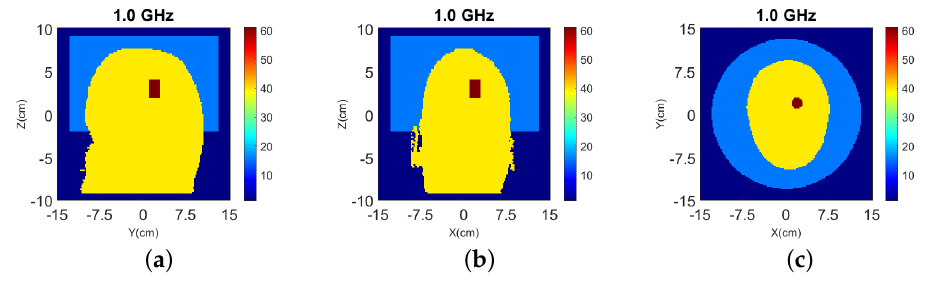
Figure 15. True values of (cid:60) ( ε r ) of Case III at 1.0 GHz: ( a ) y-z slice, ( b ) x-z slice, and ( c ) x-y slice. Results from 3-D and 2-D reconstructions are shown in Figure 16.